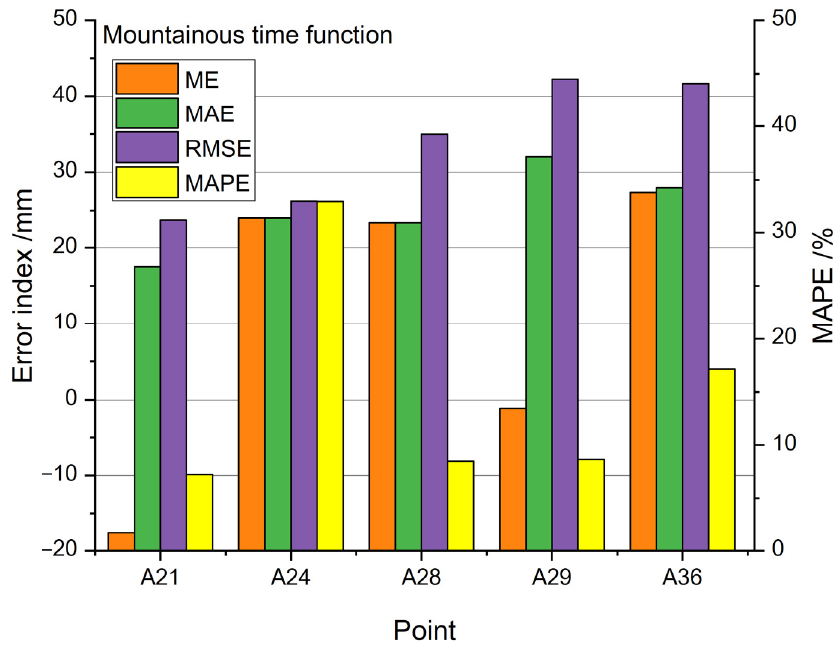
Figure 12. Error indexes of the typical points using the mountainous time function method.